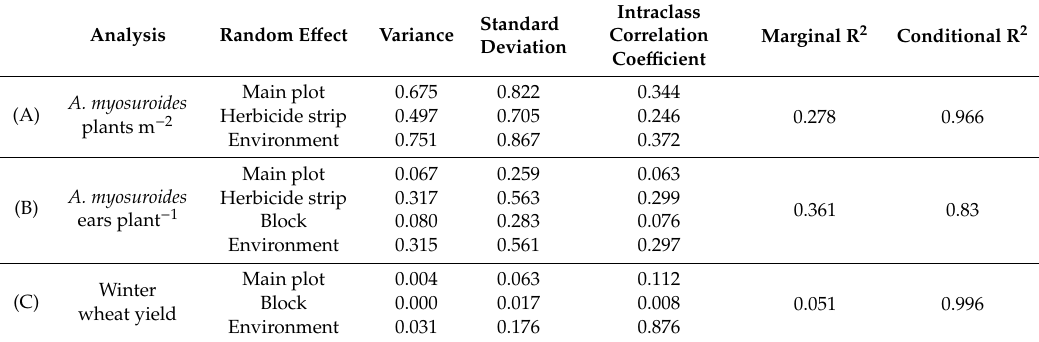
Table 1. Summary of generalized linear mixed model results with: ( A ) Alopecurus myosuroides density as dependent variable, ( B ) A. myosuroides ears plant − 1 as dependent variable, and ( C ) winter wheat yield as dependent